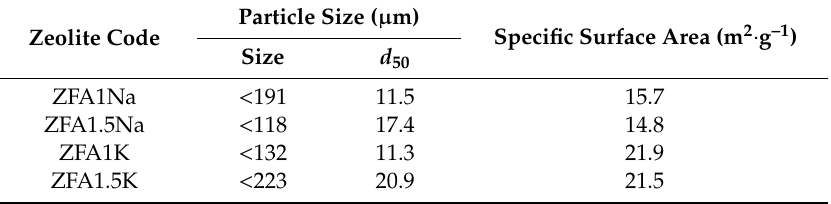
Table 2. Particle size (μm) and surface area (m 2 ·g −1 ) of the synthetic zeolites.